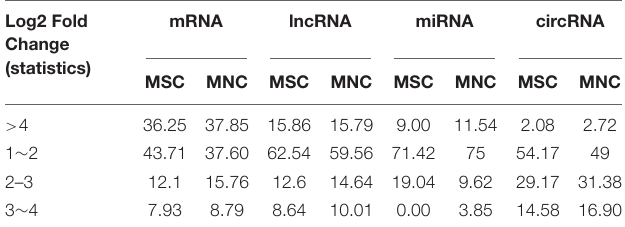
TABLE 3 | Summary of distribution of indicated